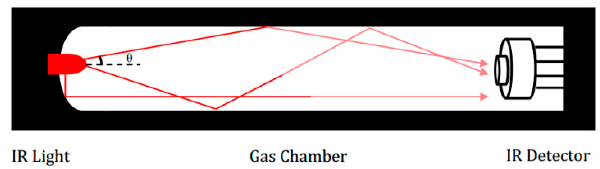
Figure 4. Schematic diagram of Non Dispersive Infrared (NDIR) system.